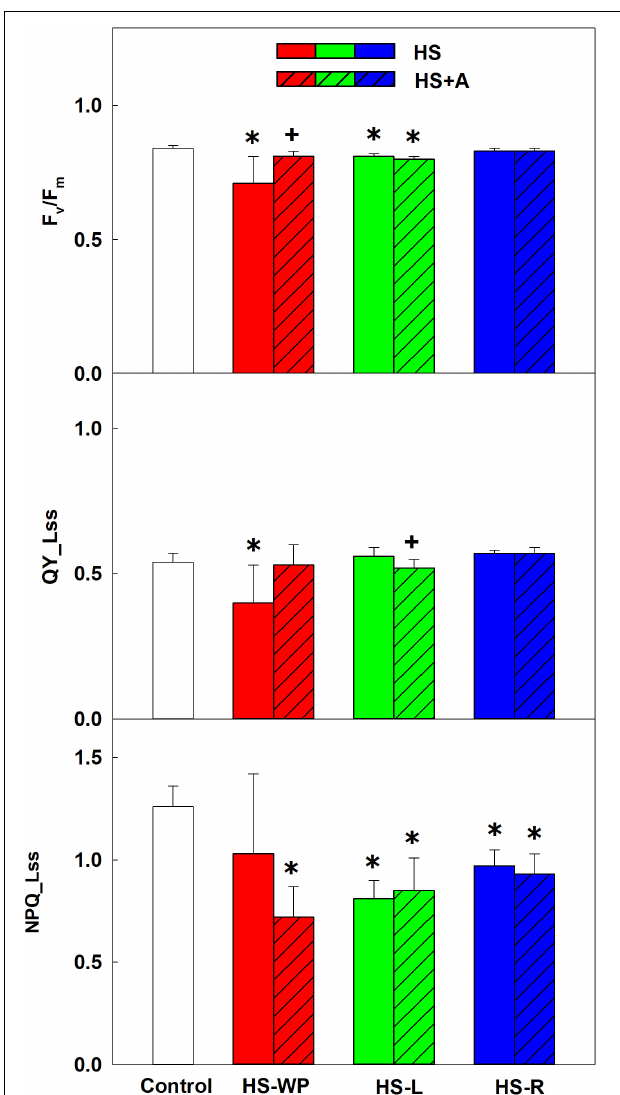
FIGURE 1 | Photosynthetic parameters: the maximum quantum yield of PSII in the dark-adapted state (F v /F m ), steady-state quantum yield (QY _ Lss ) and non-photochemical quenching (NPQ _ Lss ) of PSII. Rice seedlings were exposed to heat stress directly (HS) or after acclimation (HS + A). Heat stress was applied to whole plants (HS-WP), to leaves (HS-L), or to roots (HS-R). The first leaf was measured. Data are means ± SD. One-way ANOVA with Tukey’s post hoc test ( p < 0.05, n = 9) was used to compare controls to the HS treatments. Significant differences compared to control plants are indicated by asterisks ( ∗ ) while crosses (+) indicate significant differences between HS and HS + A treatments.